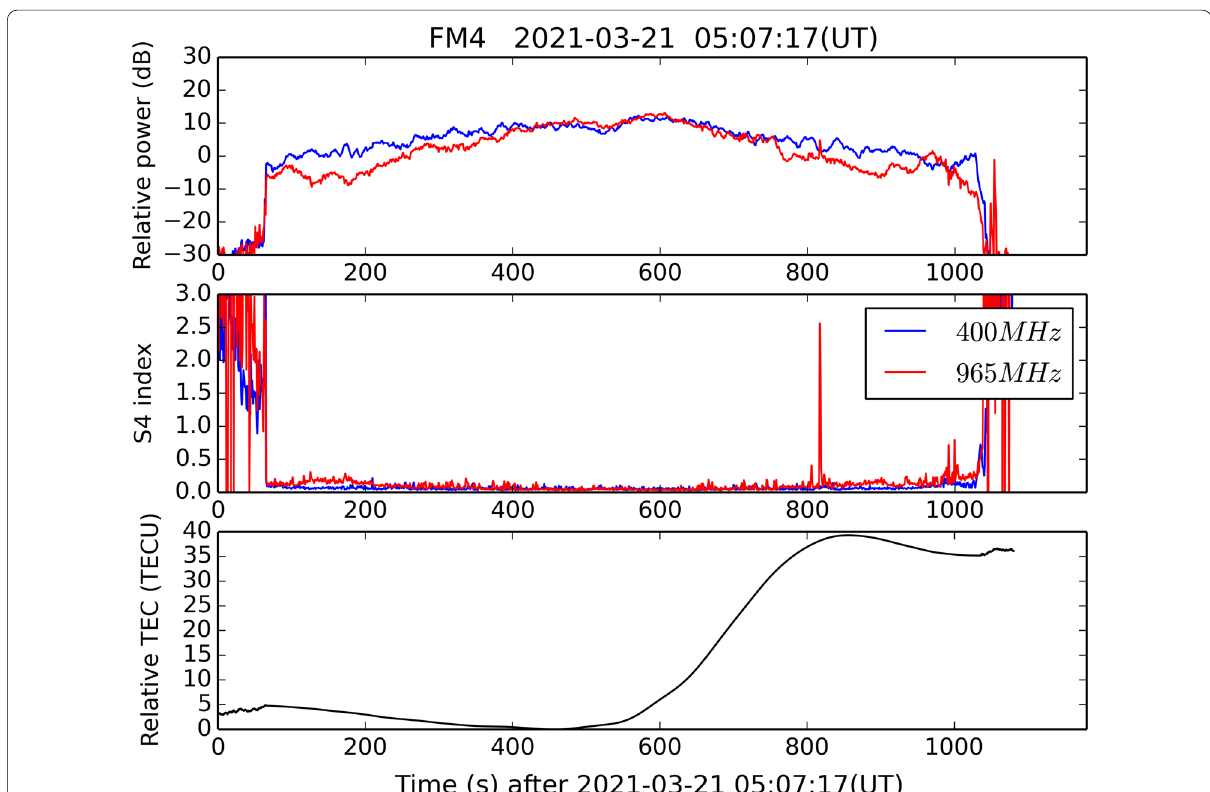
Fig. 3 Relative power (dB) (Top), S4 index (Middle) and Relative TEC (bottom) from FORMOSAT‑7/COSMIC‑2 FM4 on March 21, 2021 at 05:07:17 UT. Data of 400 and 965 MHz signals are shown by blue and red lines, respectively